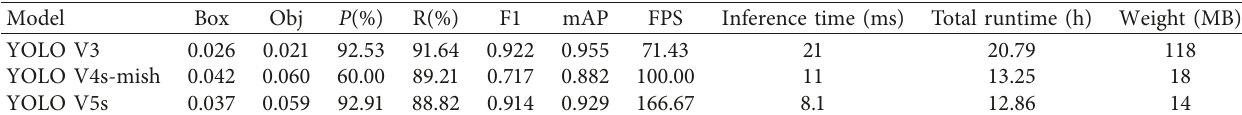
Figure 7: YOLO v4 training result graph. (a) Box, (b) objectness, (c) precision, (d) recall, (e) Val GloU, (f) Val Objectness, (g) mPA@0.5, and (h) mPA@0.5:0.95. Table 7: Evaluation indicators of three models.